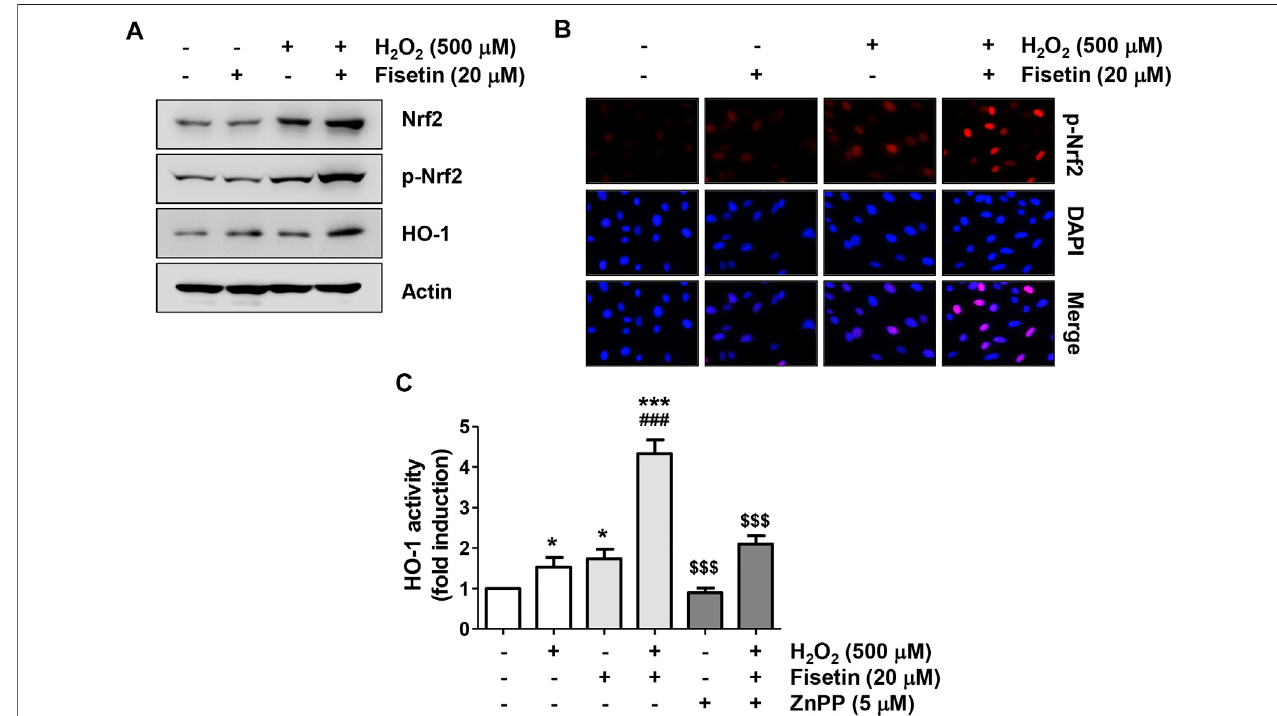
FIGURE 5 | Fisetin activated Nrf2-mediated activation of HO-1 in H 2 O 2 -treated ARPE-19 cells. Cells were pretreated for 1 h with or without 20 μ M fi setin or 5 μ M ZnPP,andthentreatedwith500 μ MH 2 O 2 foranother24 h. (A) TotalproteinwasisolatedandfollowedbyWesternblottingwasperformedusingantibodiesagainstNrf2, p-Nrf2, and HO-1. The expression of Nrf2 and HO1, as well as the phosphorylation of Nrf2 were enhanced by pretreatment of fi setin. (B) After treatment, cells were double-stained with p-Nrf2 (red) and DAPI (blue), and representative immuno fl uorescence images observed are shown. Phosphorylated form of Nrf2 was over- expressedinthenucleusfollowingpretreatmentof fi setin. (C) TheactivityofHO-1wasmeasuredbytheHO-1activityassaykit.TheincreasedactivityofHO-1incellsco- treated with fi setin and H 2 O 2 was signi fi cantly restored in the presence of ZnPP, a speci fi c inhibitor for HO-1. Results are presented as mean ± SD ( n = 4, * p ˂ 0.05 and *** p ˂ 0.001, compared with the control group; ### p ˂ 0.001 compared with H 2 O 2 treatment group. $$$ p ˂ 0.001 compared with fi setin + H 2 O 2 treatment group.